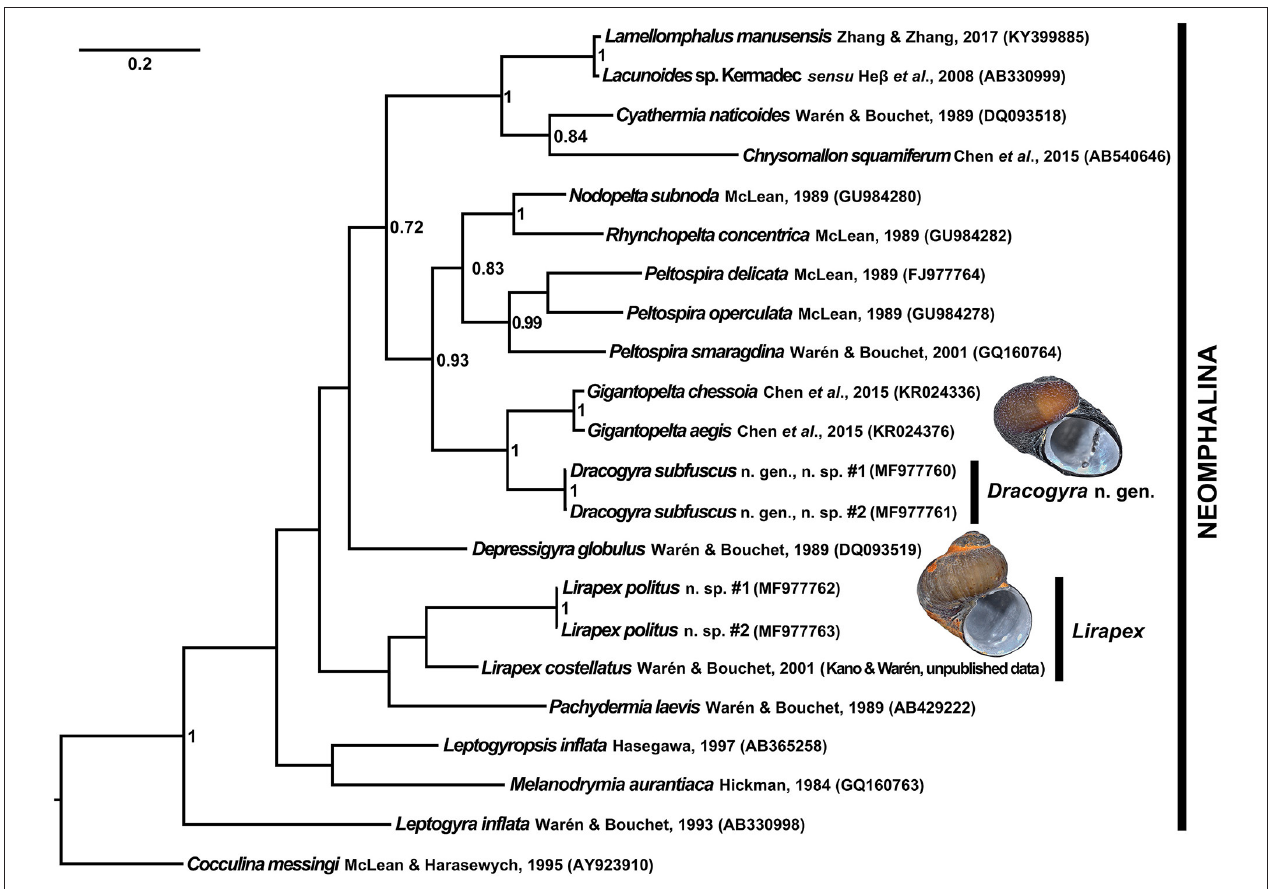
FIGURE 8 | Bayesian inference consensus tree generated from a 569 bp alignment of the COI barcoding fragment. GenBank accession numbers are shown in brackets. Node values are Bayesian posterior probabilities, only those above 0.70 are shown. Individuals of the two new species sequenced were from the type locality (“Tiamat” Chimney/DFF11, Longqi field), images shown are shells of the sequenced individual #1 for each